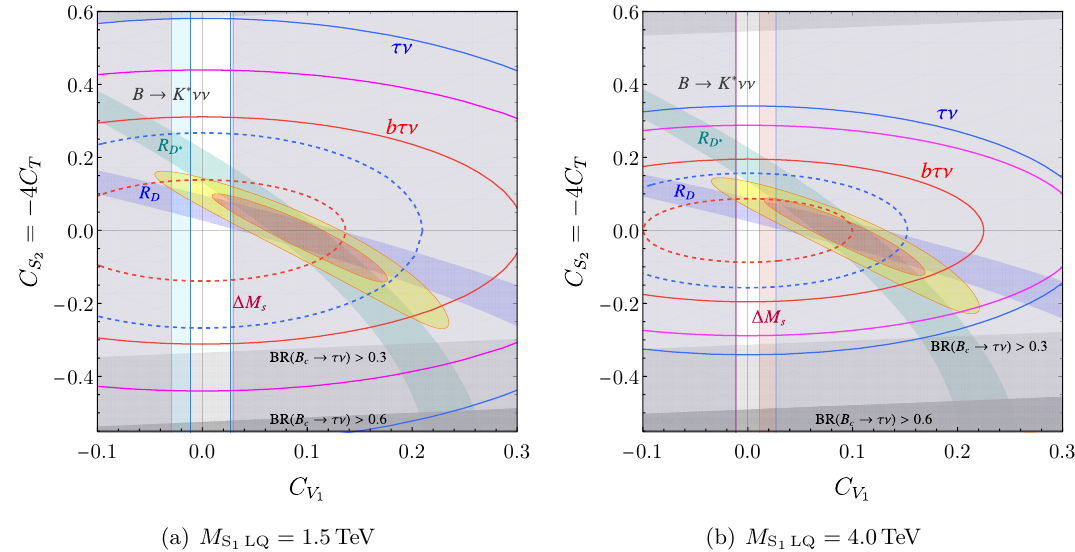
Figure 3 . The S 1 LQ scenario with M LQ = 1 . 5 TeV and 4 . 0 TeV on the ( C V color convention is the same as in figure 2. The magenta lines are the current bound from the R L dt experimental data with = 36 fb − 1 by assuming M LQ = 2 TeV (left panel) and the EFT limit (right panel) [35]. In addition, the cyan-shaded region is excluded by the B → K ∗ νν measurement at the 90% CL, and the red-shaded region is excluded by ∆ M s